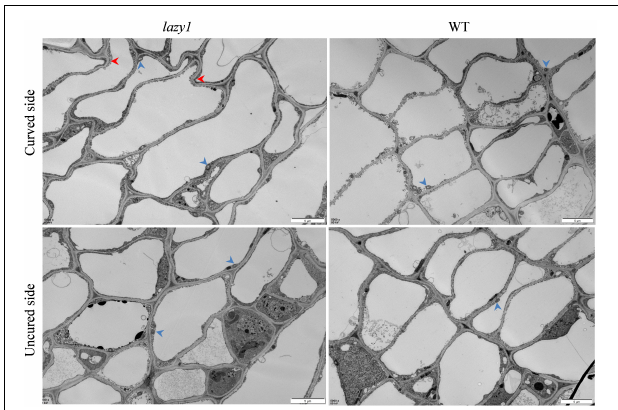
FIGURE 2 | Microscopic observation of lazy1 bending stem. Red arrows point to the impaired cells wall and blue arrows point to the starch granules. Scale bar = 5 µ m.